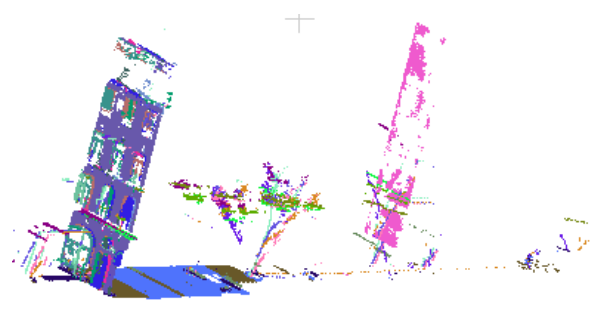
Figure 6. Inliers of the estimated planes from an outdoor scan computed with Sensor topology based RANSAC